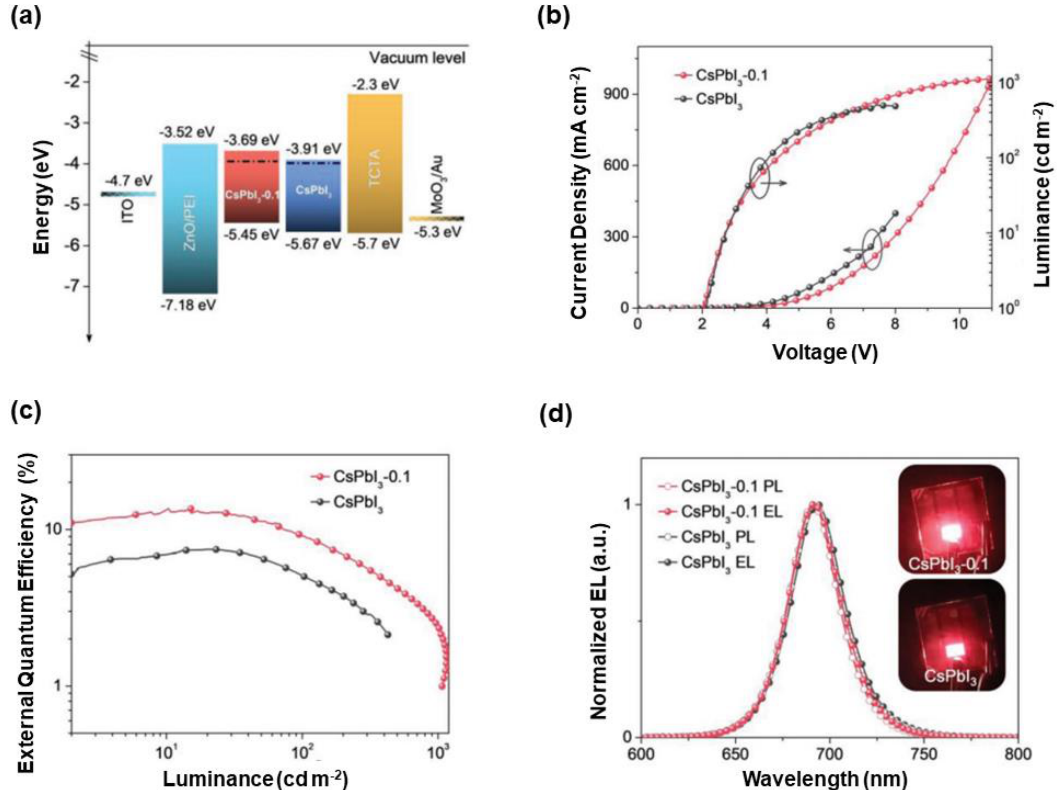
Figure 7. ( a ) Energy level diagram of PeLEDs. ( b ) Current density and luminance the CsPbI 3 and CsPbI 3 -0.1 PeLEDs. ( c ) EQE of PeLEDs. ( d ) PL and EL spectra of PeLEDs. Inset: photographs of